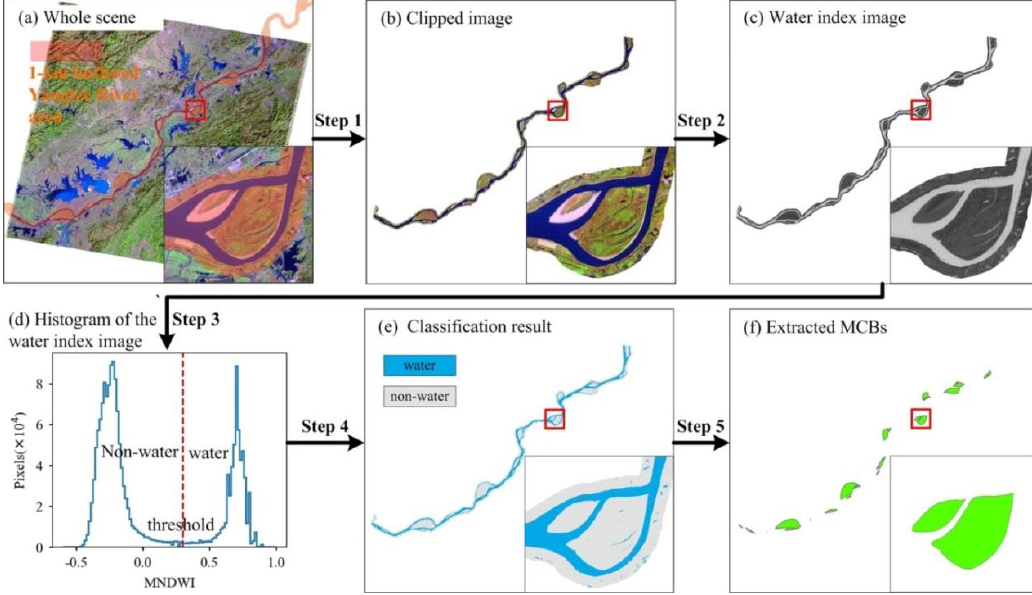
Figure 3. Main steps for automatic extraction of MCBs. ( a ) The whole scene of Landsat-5 image in false color (R: Band 5, G: Band 4, and B: Band 3) acquired, for example on 14 January 2010 (path=121, row=039). ( b ) Clipped image by the 1-km buffered Yangtze River polygon GIS data. ( c ) Water index image generated by the algorithm of the modified normalized difference water index [49]. ( d )